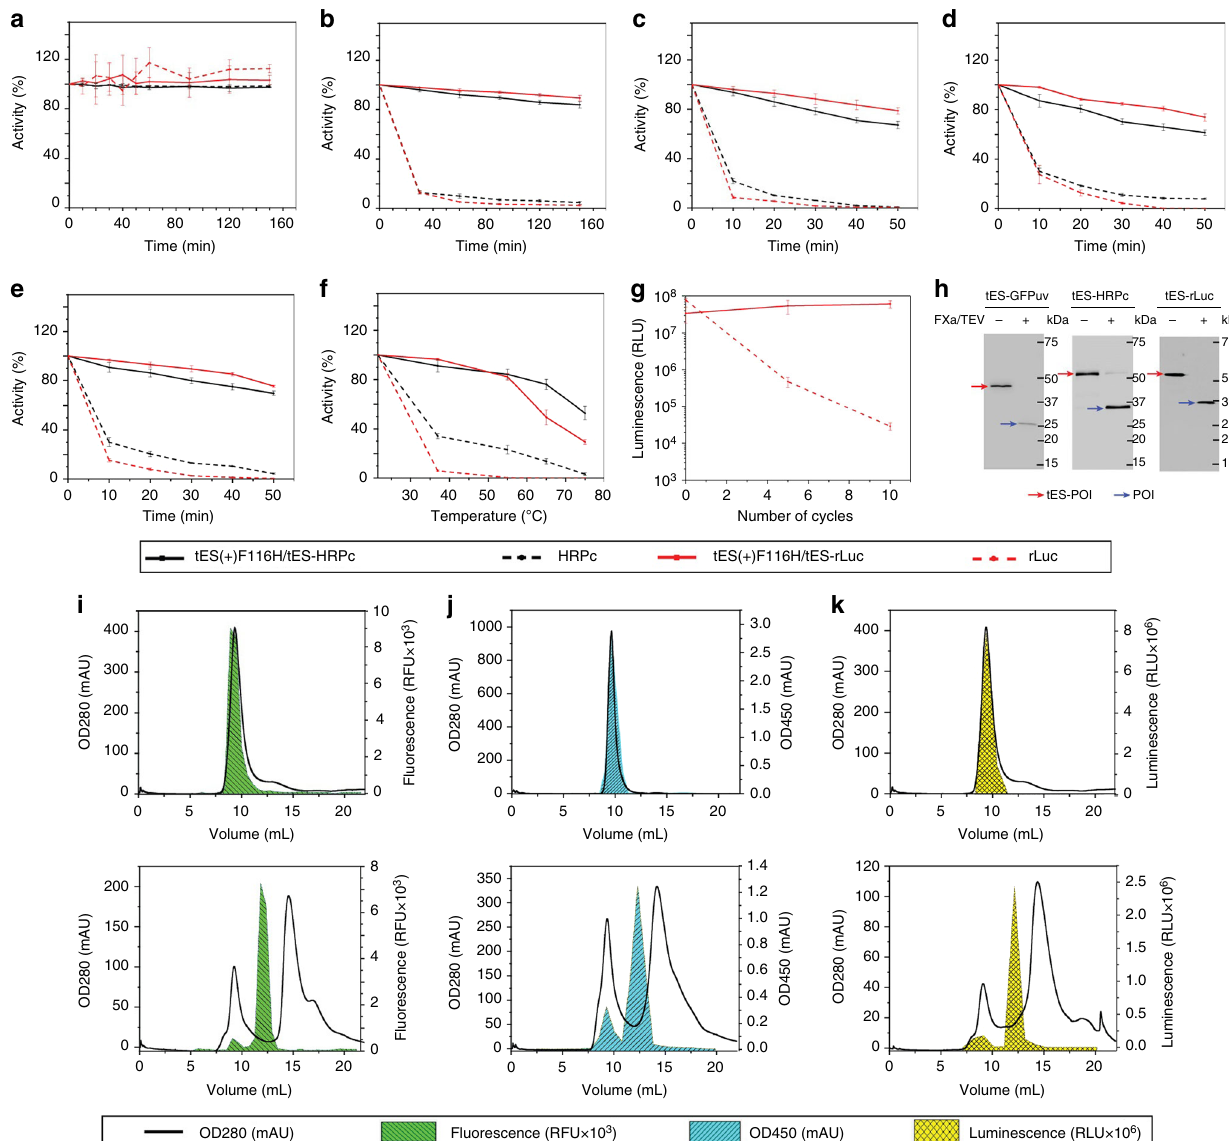
Fig. 3 Effect of tES on the stability of the encapsulated POI and the release of the POI with mild pH titration. a POI is stable in the dialysis buffer with and without encapsulation. The presence of tES enhanced the stability of tES-POI in b 0.4% trypsin, c 20% methanol, d 8 M urea, and e 30% acetonitrile. f tES (+)F116H/tES-POI is resistant to 15 min of thermal denaturation. g tES(+)F116H/tES-rLuc is highly resistant to repeated thermocycling (80 °C × 5 min × 10 cycles) showing a three order-of-magnitude higher activity compared with rLuc. h Recovery of active proteins from the tES. tES(+)F116H/tES-GFPuv, tES(+) F116H/tES-HRPc, and tES(+)F116H/tES-rLuc were subjected to pH 5.8 which resulted in the cage break and release of tES-POI. The released tES-POI (MW of tES-GFP [46 kDa], tES-HRPc [53 kDa], and tES-rLuc [55 kDa]) was proteolyzed by FXa/TEV to separate GFPuv (27 kDa), HRPc (34 kDa), and rLuc (36 kDa) from the tES subunit (19 kDa). The separated POIs were detected on the western blot using c-Myc antibody targeted to the c-Myc epitope downstream of POIs. i – k Size-exclusion chromatography of tES(+)F116H/tES-GFPuv, tES(+)F116H/tES-HRPc, and tES(+)F116H/tES-rLuc at pH values of 8.0 (upper panels) and 5.8 (lower panels). Each fraction was analyzed for GFPuv, HRPc, and rLuc activity and the data were overlaid on the respective chromatogram. All experiments were performed in triplicates and error bars represent means ± standard deviation